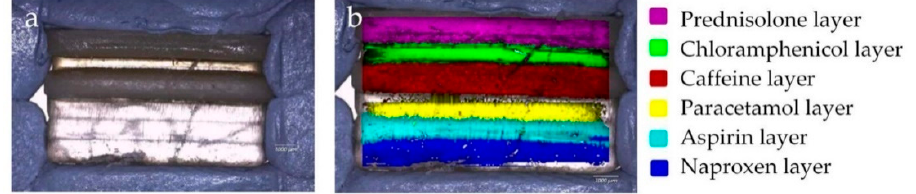
Figure 39. Visual presentation of a (multilayer) polypill under: ( a ) optical microscope and ( b ) Raman mapping. Each layer presents a different drug printed layer. Work reproduced from [332]. Table 6. Applications of multi-material vat photopolymerization in various bio-medical